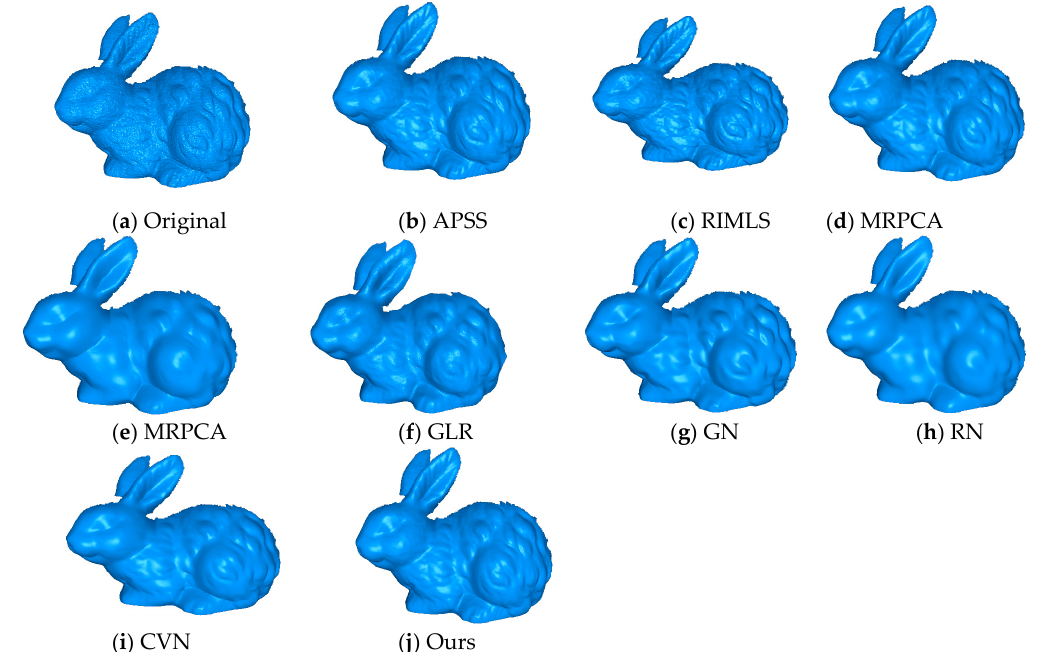
Figure 7. The rabbit model, with natural noise. We can see that the proposed method was able to preserve sharp features effectively when compared to the state-of-the-art methods. The surface was reconstructed using the ball pivoting algorithm.